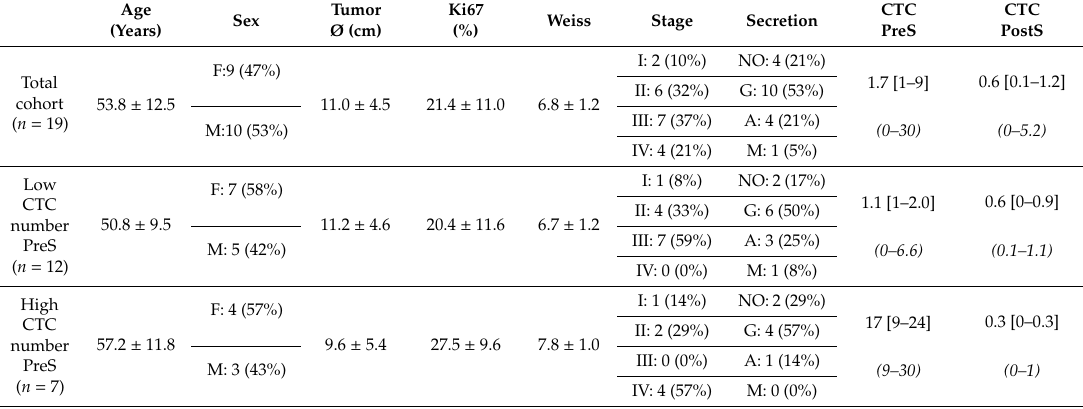
Table 1. Characteristics of the adrenocortical carcinoma (ACC) patients and of the tumors along with circulating tumor cell (CTC) number in pre-surgery (PreS) and post-surgery (PostS) blood samples. Data from the whole cohort of patients or when patients were stratified in low and high number of CTCs in PreS samples (PreS) using the 75th percentile of PreS CTC distribution as cut o ff are shown. Age Tumor Ki67 Sex Weiss Ø (cm) (%) (Years) Data are expressed as mean ± SD for parametric (age, tumor diameter, Weiss, Ki67%), or median [25– 75 percentiles] for non ‐ parametric continuous variables, and as absolute number and percentage of patients for non ‐ continuous variables (sex, stages, secretion type—G: glucocorticoids, A: androgens, M: mineralocorticoids). Data intervals (min ‐ max) are indicated in italics in brackets. Italics specifically indicates data interval (min ‐ max).